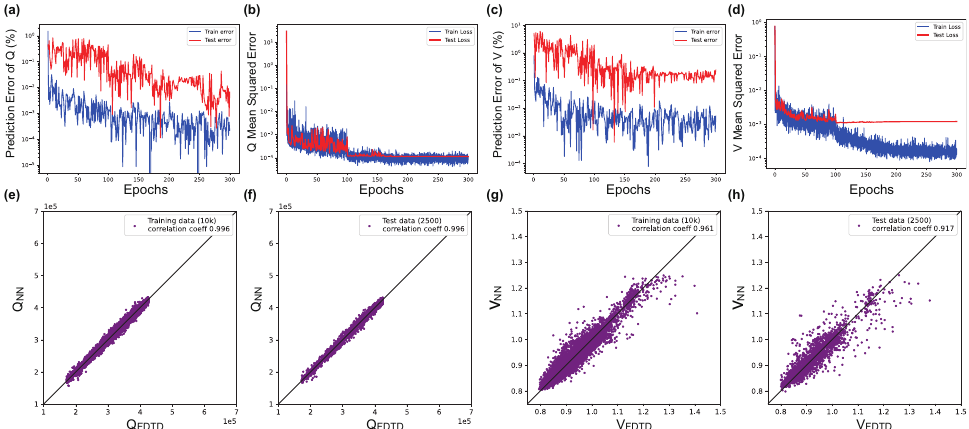
Figure 3. Learning curves and training results for POViT when ABS is used as the activation function. The four plots on the left (( a ): prediction error, ( b ): MSE, ( e , f ): correlation coefficients) are for Q , while the four on the right (( c ): prediction error, ( d ): MSE, ( g , h ): correlation coefficients) are for V . Q NN is the predicted correlation coefficient, while Q FDTD is the target correlation coefficient. Similarly, V NN and V FDTD are the predicted and target correlation coefficient, respectively.